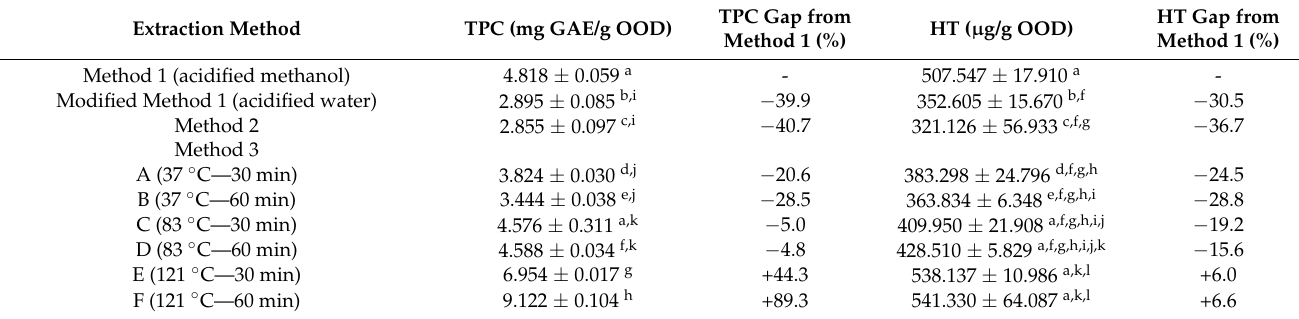
Table 2. Extraction yields obtained using different